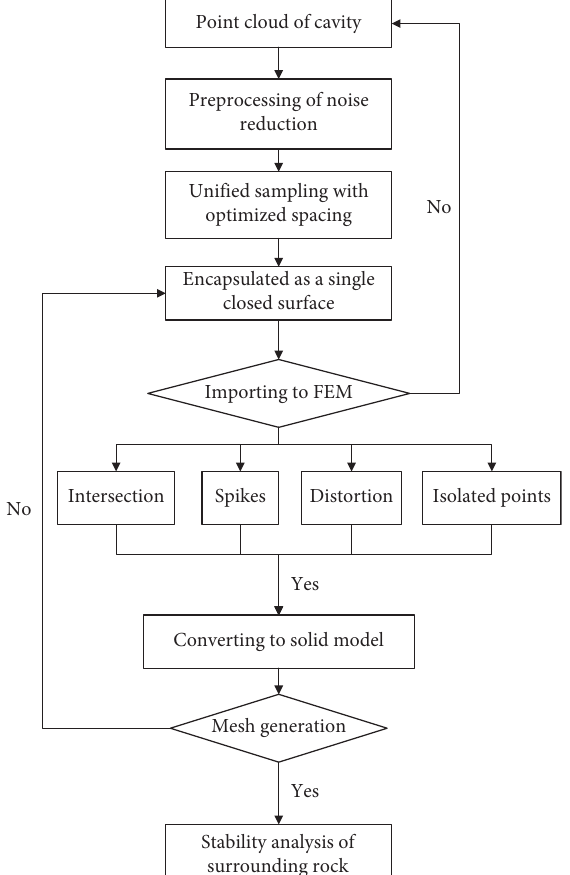
Figure 8: Geomagic-COMSOL coupling calculation flow chart.